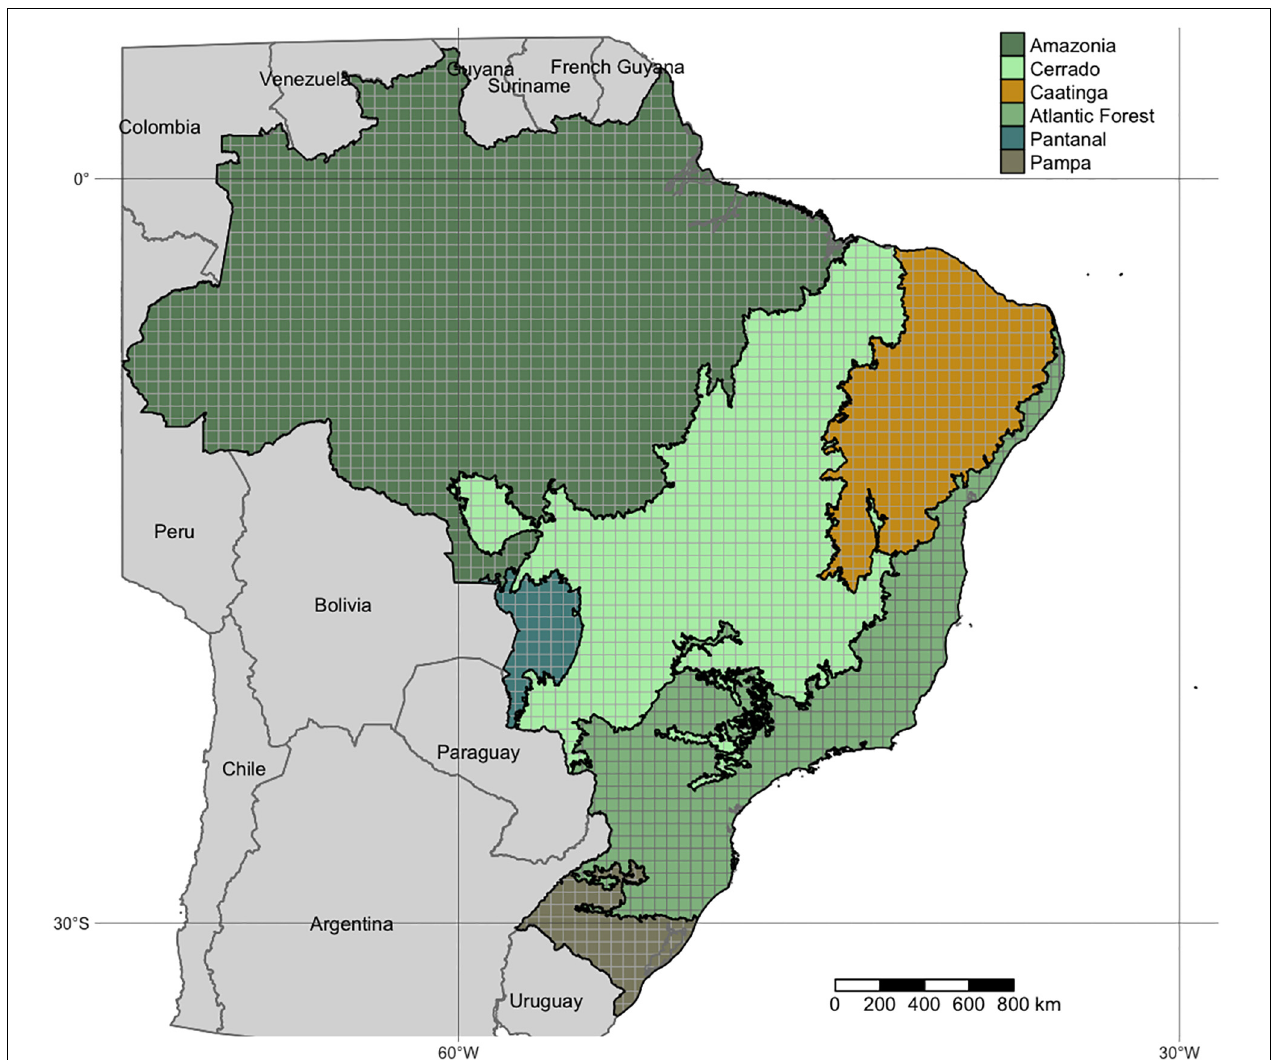
FIGURE 1 | Brazilian biomes and the grid used for the analysis (cell size = 0.5 × 0.5